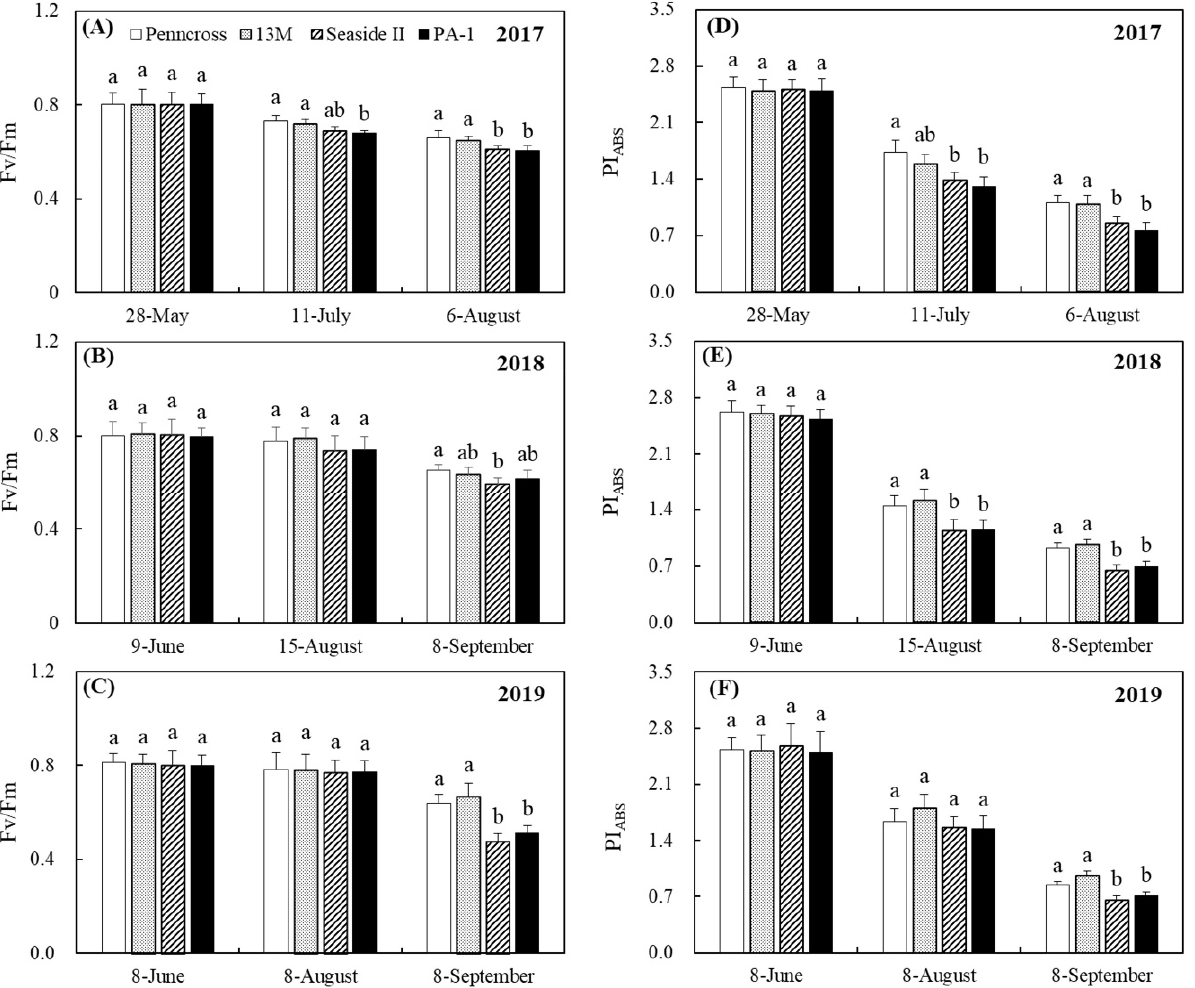
Figure 4. Change in ( A – C ) photochemical efficiency (Fv/Fm) and ( D – F ) performance index on absorption basis (PIABS) of four different creeping bentgrass cultivars (Penncross, 13M, Seaside II, and PA-1) during summer in ( A ) 2017, ( B ) 2018, and ( C ) 2019. Vertical bars indicate ±SE of mean (n = 4). Different letters indicate significant differences ( p < 0.05) at a given day.